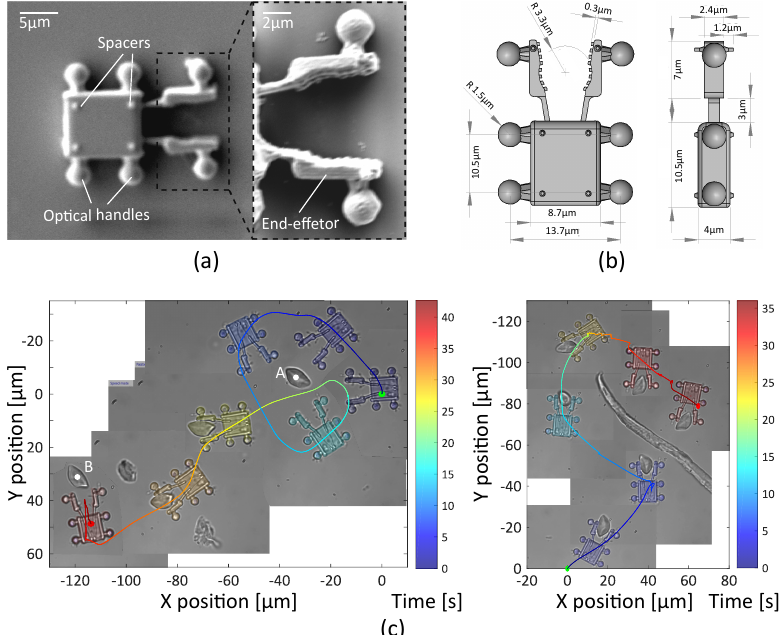
Figure 9. Robot equipped with a fork end-effector for single-cell manipulation. ( a ) Scanning electron microscopy (SEM) image of the robot. ( b ) Schematic depictions with dimensions of optical robot. ( c ) Two sets of experiments manipulation of a single red blood cell and its 2D trajectory. Please see Supplementary Video S4 for complete footage of these